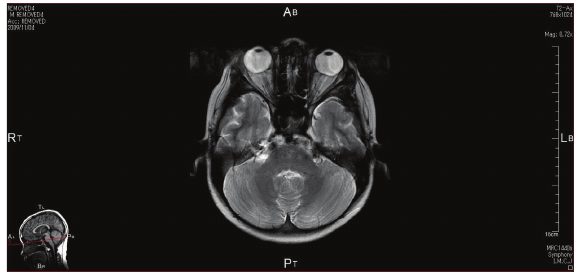
Figure 6: MRI findings of the patient with follicular lymphoma. MRI image shows thickening of the optic nerve sheaths causing “tram track”